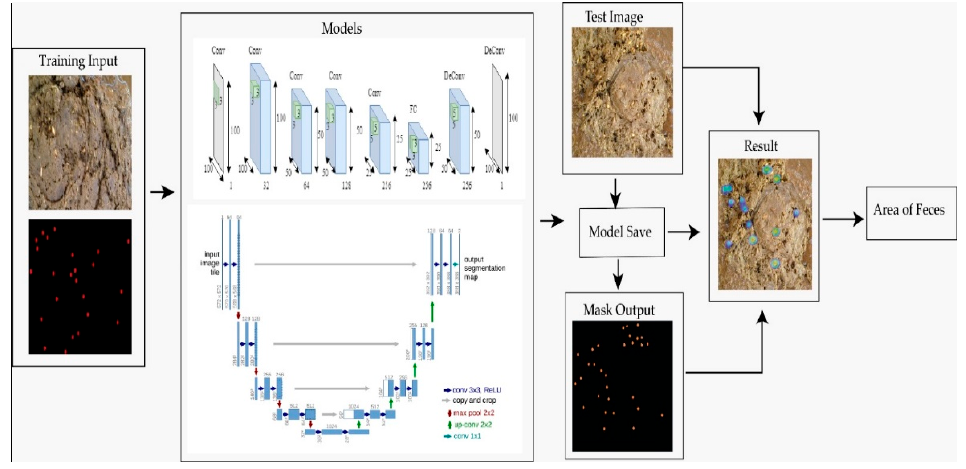
Figure 1. Flowchart for model implementation.